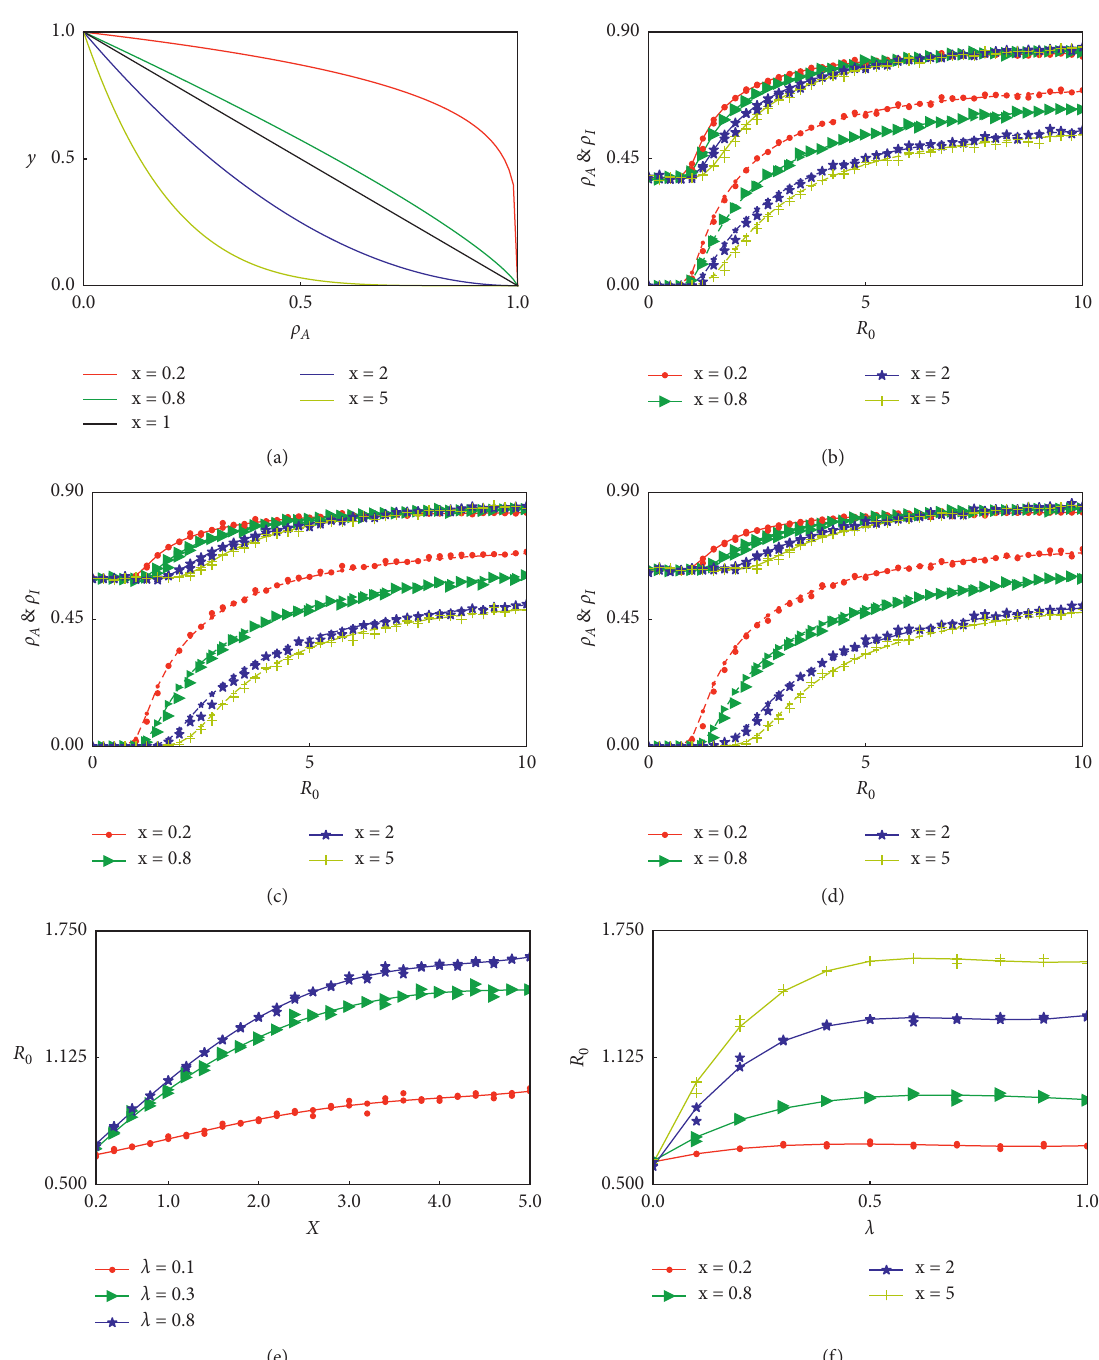
Figure 4: (a) Plots of the function c � ( 1 − ρ ) x for different x values. The dependence of prevalence ρ A shown in (b) for λ � 0 . 1, (c) for λ � 0 . 3, and (d) for λ � 0 . 8. Solid lines represent the ratio of awareness nodes ρ A and dashed lines represent the ratio of infected nodes. Symbols represent the simulation results and different colors correspond to different x values. (e) Dependence of the critical infection rate R for the epidemic outbreak on parameter x . (f) Dependence of R 0 c